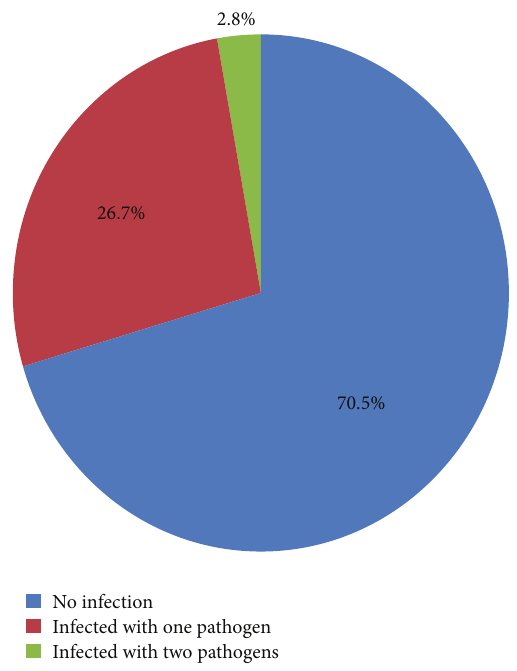
Figure2:Infectionstatusofblooddonorsbybloodbornepathogens at Wolaita Sodo Teaching Referral Hospital